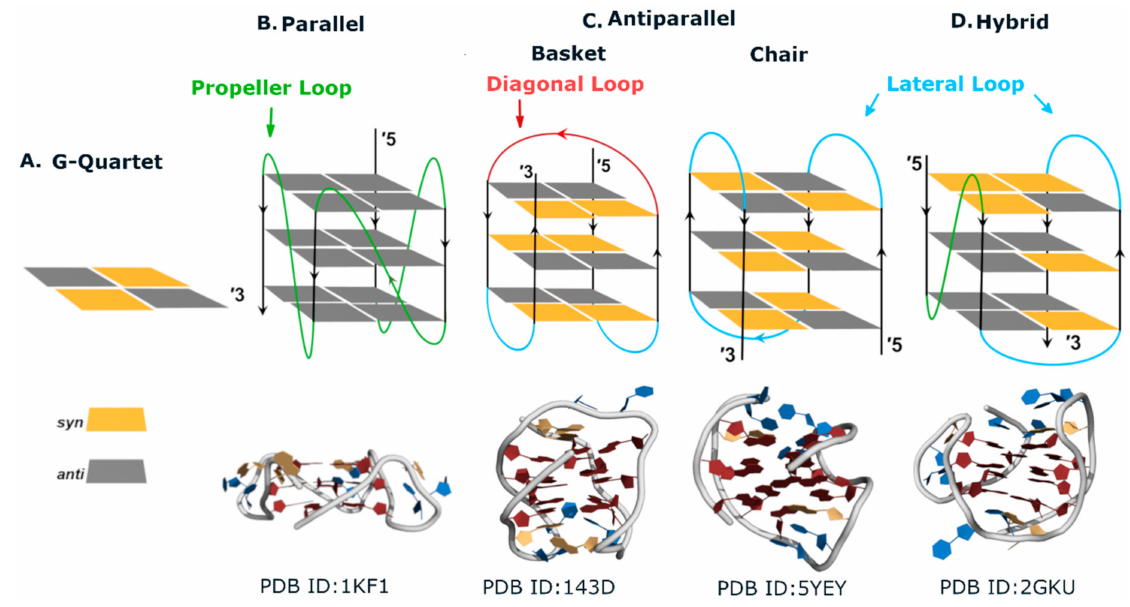
Figure 2. Topologies of intramolecular G-quadruplexes (G4). ( A ) Illustration of a G-quartet where squares represent guanine residues. Colour scheme of guanosine glycosidic bond angles: anti is represented in grey and syn in yellow. ( B ) Top: illustration of a parallel G4 formed by three stacked G-quartets linked by propeller loops. Bottom: representation of the structure of the telomeric parallel G4 determined in solution (PDB ID 1kf1). ( C ) Top: illustration of G4s arranged in antiparallel topologies. In the “chair-type” conformation, all loops are lateral, whereas lateral and diagonal loops tie up the “basket-type” conformation. Bottom: representation of an antiparallel (basket) structure (PDB ID 143D) and an antiparallel (chair) structure (PDB ID 5YEY). ( D ) Top: illustration of a hybrid G4 in which the propeller and lateral loops link G-quartets. Bottom: representation of the structure of a hybrid G4 (PDB: